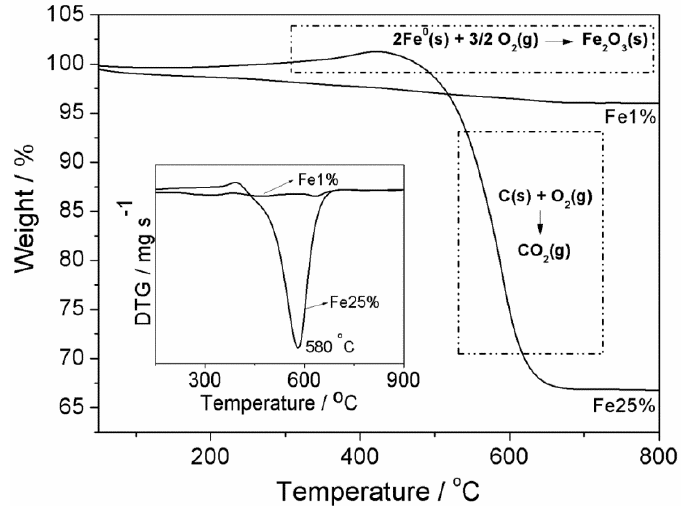
Figure 3. TG/DTG curves of magnetic amphiphilic nanoparticles Fe1% and